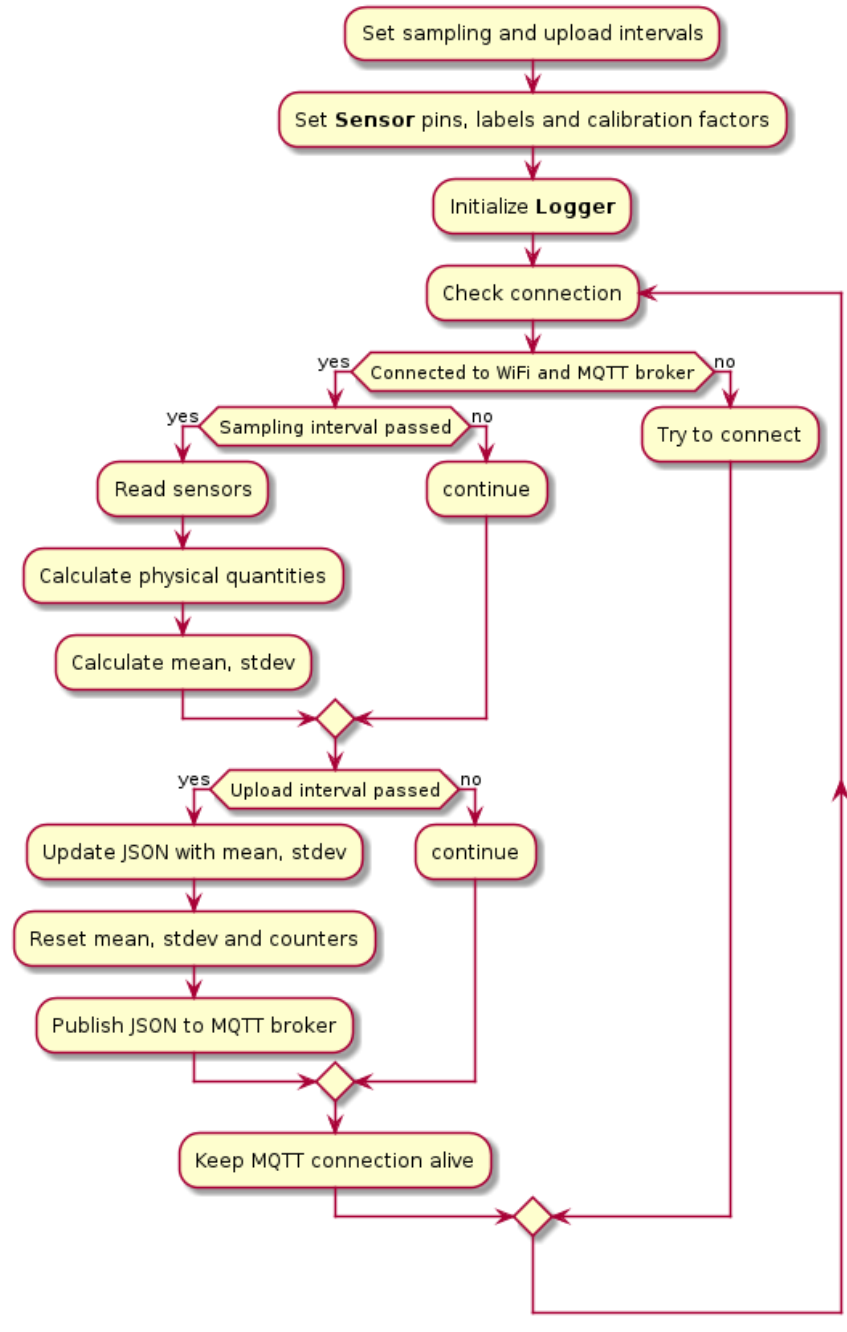
Figure 3. ESP32 software